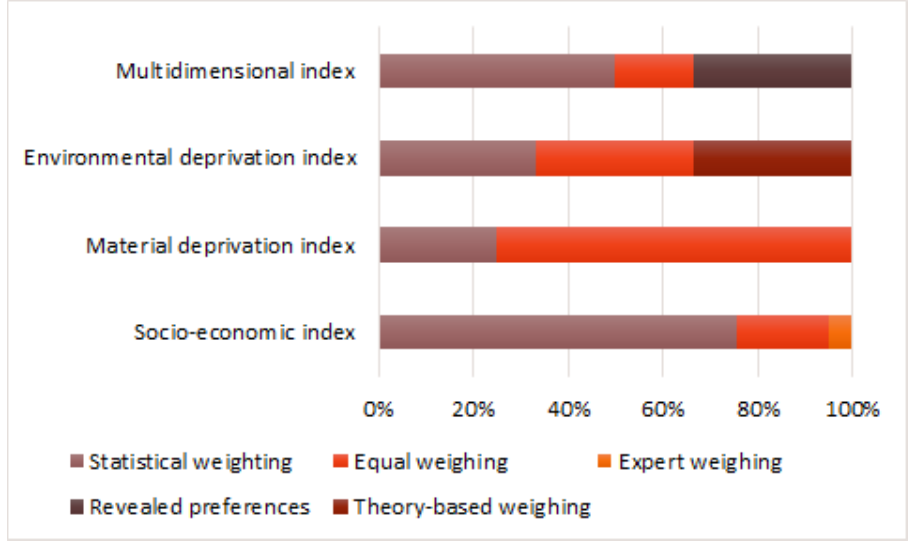
Figure 5. Original deprivation indices grouped by weighting method.